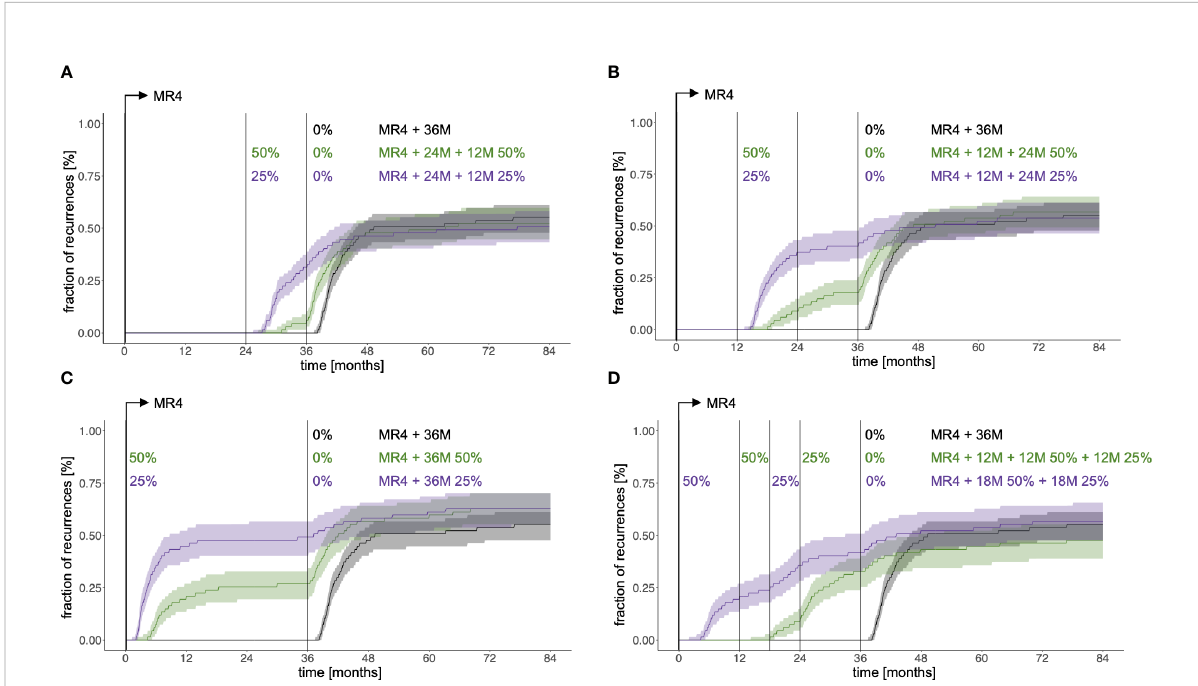
FIGURE 5 Fraction of recurrences as a function of time comparing immediate therapy cessation 36 months after reaching MR4 (black) with different scenarios of dose reduction covering the same overall treatment duration: (A) 24 months full dose treatment past reaching MR4 plus 12 month dose reduction to 50% of the initial dose (green, indicated as MR4+24M+12M50%) and 24 months full dose treatment past reaching MR4 plus 12 month dose reduction to 25% of the initial dose (purple, indicated as MR4+24M+12M25%). (B) 12 months full dose treatment past reaching MR4 plus 24 month dose reduction to 50% of the initial dose (green, indicated as MR4+12M+24M50%) and 12 months full dose treatment past reaching MR4 plus 24 month dose reduction to 25% of the initial dose (purple, indicated as MR4+12M+24M25%). (C) dose reduction to 50% of the initial dose for 36 months immediately after reaching MR4 (green, indicated as MR4+36M50%) and dose reduction to 25% of the initial dose for 36 months immediately after reaching MR4 (purple, indicated as MR4+36M25%). (D) 12 months full dose treatment past reaching MR4 plus 12 month dose reduction to 50% of the initial dose plus 12 month dose reduction to 25% of the initial dose (green, indicated as MR4+12M +12M50%+12M 25%) and dose reduction to 50% of the initial dose for 18 months immediately after reaching MR4 plus 18 month dose reduction to 25% of the initial dose (purple, indicated as